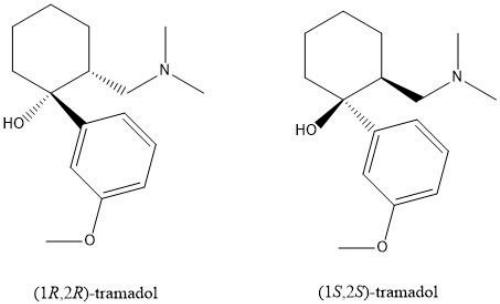
Figure 1. Chemical structure of tramadol hydrochloride.